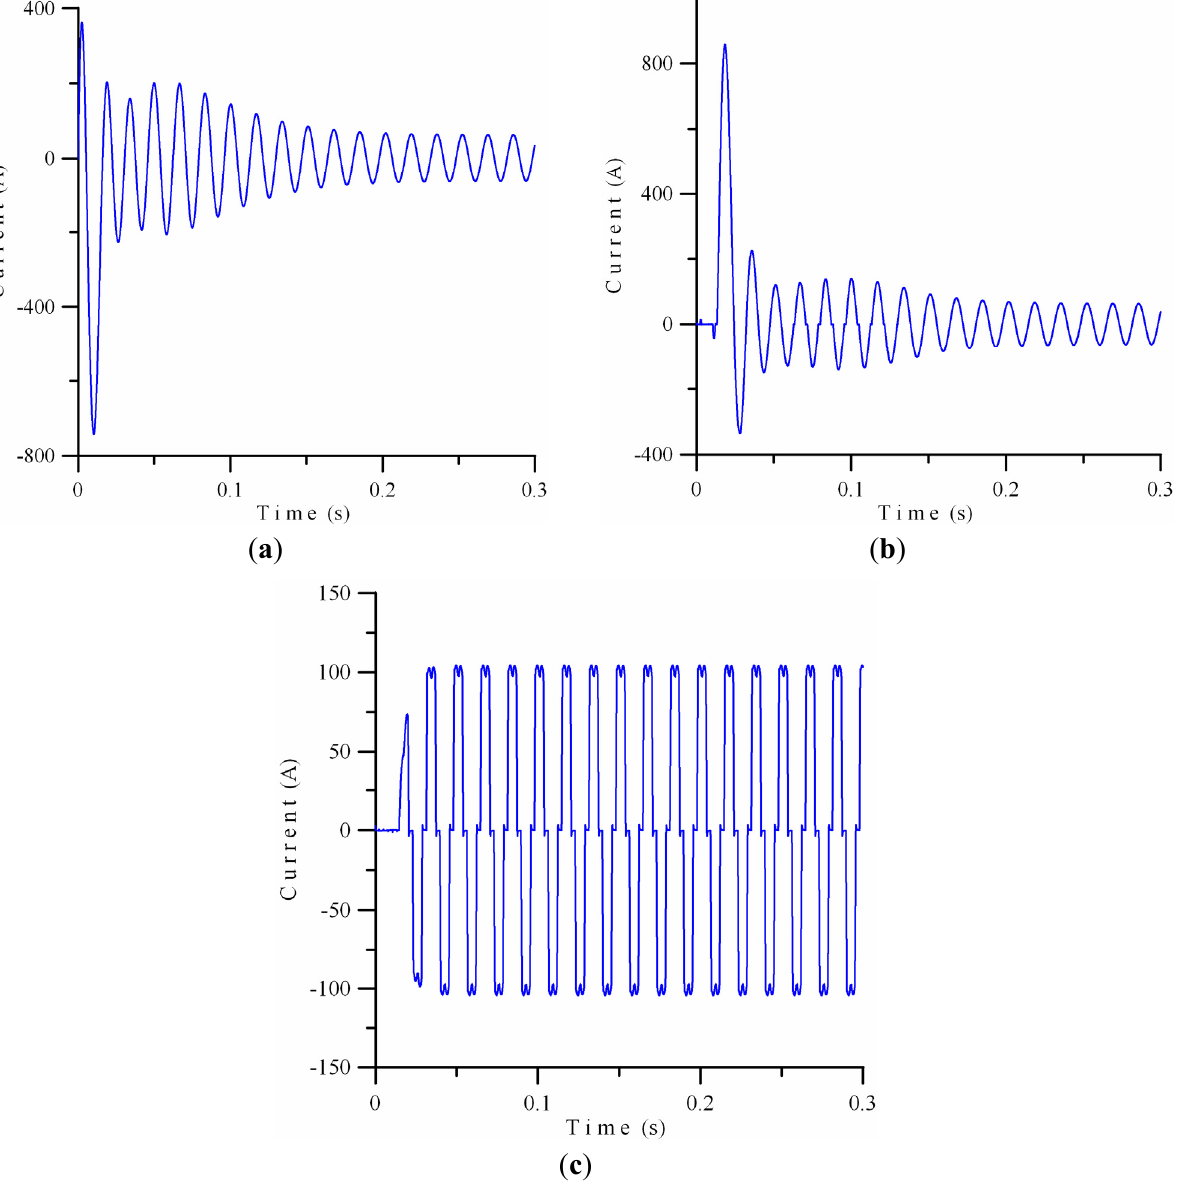
Figure 4. The current waveforms of turn-on transients. ( a ) a 160 hp induction motor; ( b ) a 123 hp induction motor driven by variable-voltage drives; ( c ) a bank of loads supplied by a six-pulse thyristor rectifier for AC